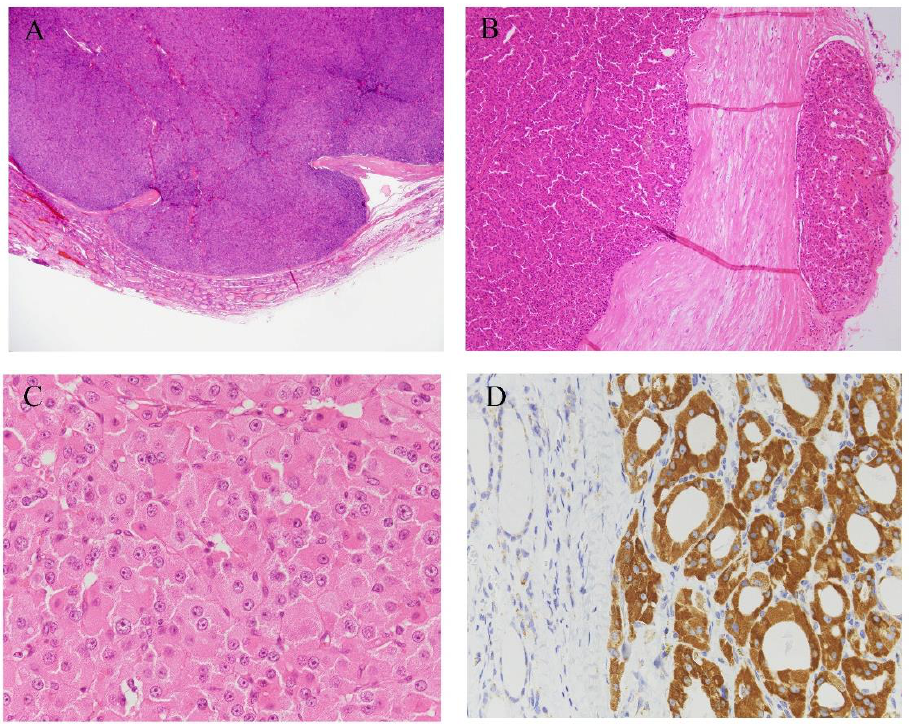
Figure 3. Histological images of HCCs. ( A ) HCC is diagnosed in cases where a Hürthle cell tumor shows capsular invasion, and/or ( B ) vascular invasion. ( C ) HCC is composed of polygonal large cells with abundant granular and acidophilic cytoplasm. HCC cells have large nuclei with prominent nucleoli. ( D ) Tumor cells are diffuse and strongly positive for anti-mitochondria antibodies. Hematoxylin and eosin stain ( A–C ), immunohistochemistry of anti-mitochondrial antibody ( D ). Original magnification, ×1.25 ( A ), ×40 ( B ), ×100 ( D ), and ×400 ( C ).